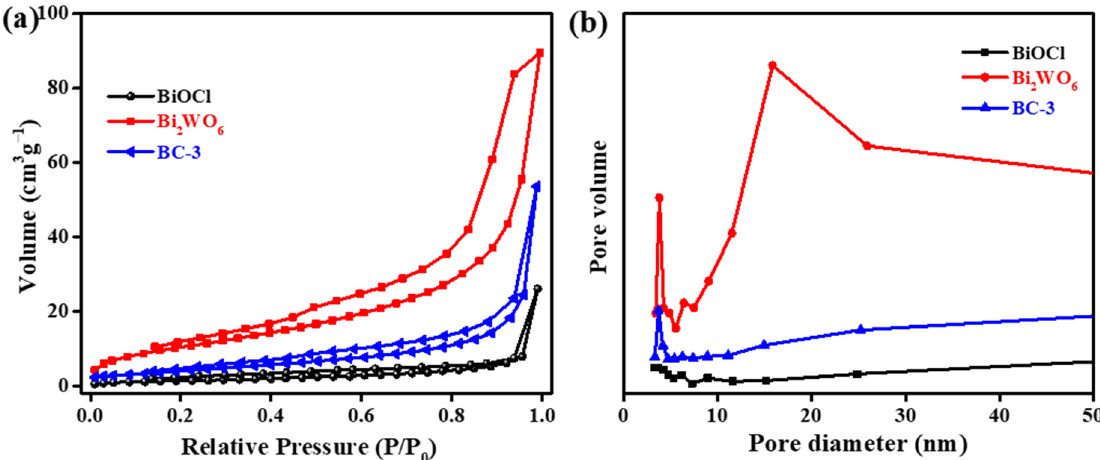
Figure 11. N 2 adsorption–desorption isotherm ( a ) and pore size distribution ( b ) of pure BiOCl, Bi 2 WO 6 , and BC-3 nanocomposite. Table 1. The S BET and average pore size of pure BiOCl, Bi 2 WO 6 , and BC-3 nanocomposite.